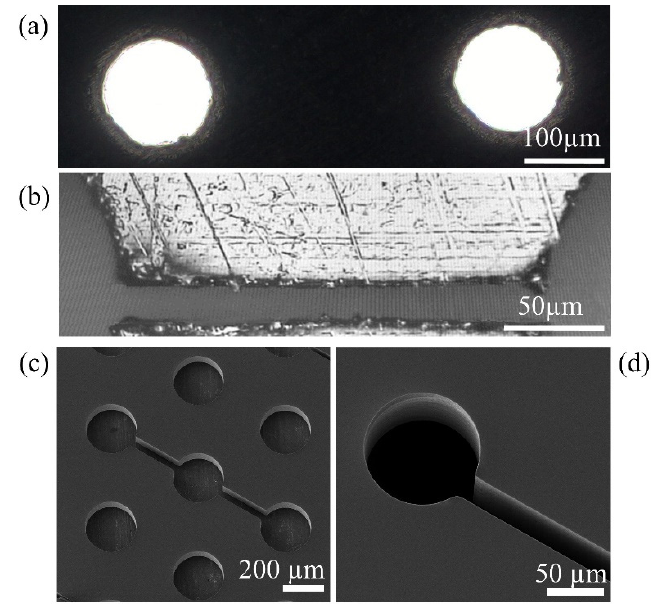
Figure 4. Details of stencil masks produced with LC of stainless-steel foils and with photo resist lithography (PRL) of silicon. ( a ) Optical micrograph of 150 μ m wide holes of LC steel mask with jagged borders (mask A, Supplementary Table S1). ( b ) Optical micrograph of a 20 μ m wide channel of LC steel mask with a re-solidified drop of metal closing-up the channel opening (mask Q13, Supplementary Table S1). ( c ) SEM image of 250 μ m wide dots with an interaxial distance of 500 μ m. The channels connecting the dots are 50 μ m wide (mask Q19, Supplementary Table S1). ( d ) SEM image of 100 μ m wide dot with a 20 μ m wide channel (mask Q16, Supplementary Table S1). Images ( c , d ) were acquired using a SEM (VEGA3 TESCAN) with a 10 kV electron beam at different magnifications.